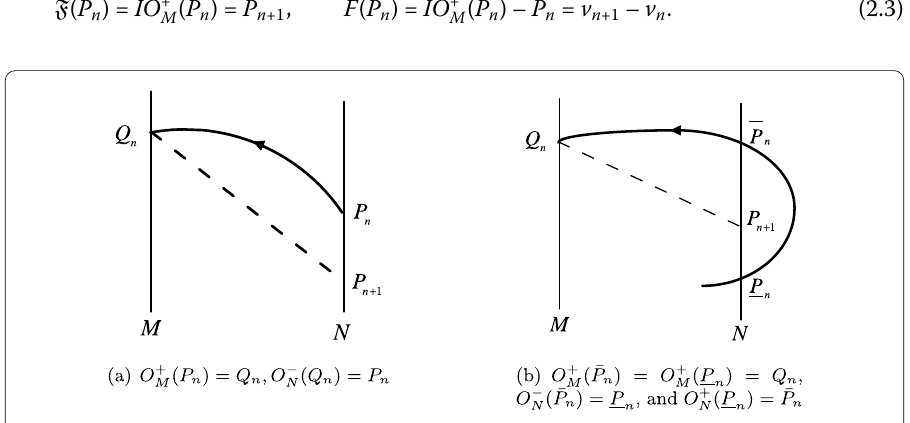
, O – , O + and I , where I ( Q n ) = P n M N N